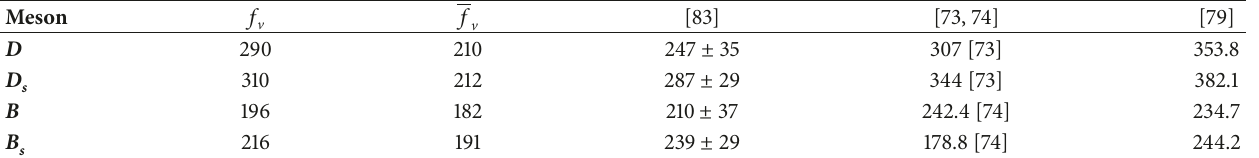
Table 8: The decay constants of vector B and D mesons in